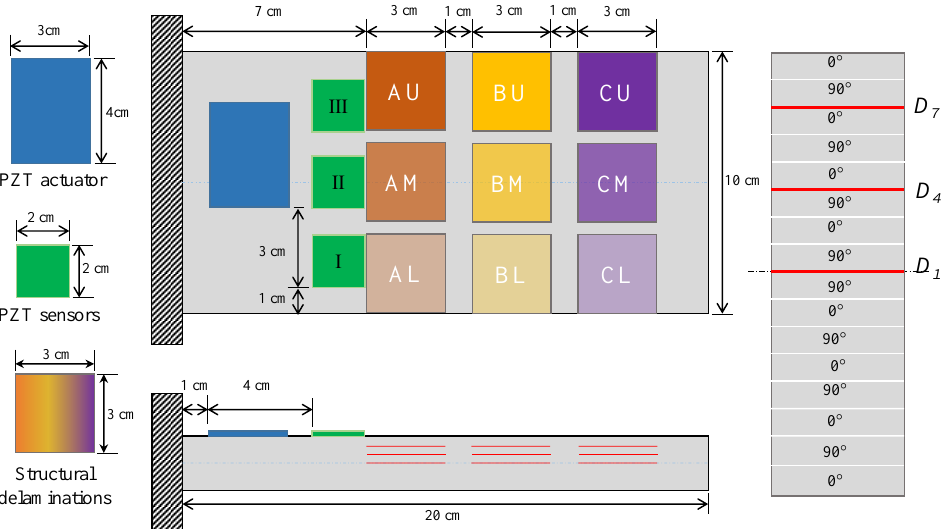
Figure 1. Schematic of smart composite laminate with various inner and edge delaminations ( left ) Top and front views ( right ) exaggerated view of the thickness direction.